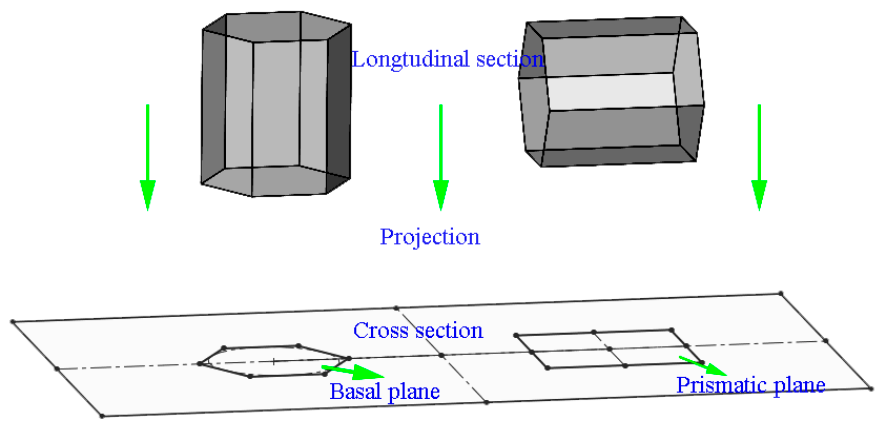
Figure 8. Sketch map of the projection.